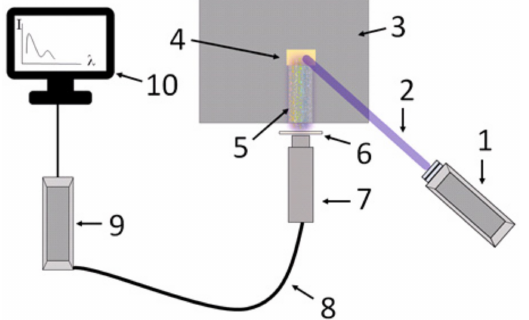
Figure 1. Schematic representation of the experimental setup based on the 405 nm continuous laser: 1—laser, 2—laser beam, 3—screen for the fixation of a sample, 4—the sample, 5—fluorescence, 6— optical filter, 7—collimator, 8—optical fiber, 9—spectrophotometer, 10—PC for registration of